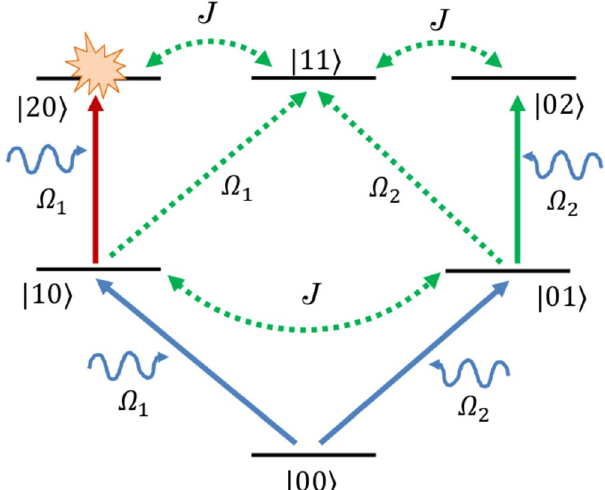
Figure 4. Different paths for two-phonon excitation when an additional pump is applied on the secondary mechanical